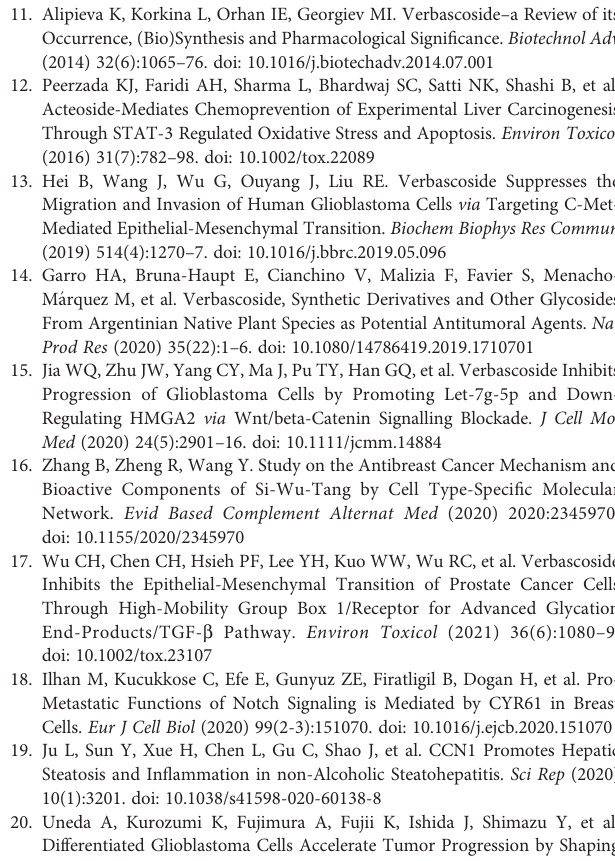
Supplementary Figure 1 | The IC50 values of VB treating A2780 and SKOV3 cells at 48 h were calculated based on the CCK8 assay. Supplementary Figure 2 | VB inhibits the malignant characteristics of OC cells via deactivating the CCN1-mediated AKT/NF- k B pathway. (A) The viability of A2780 and SKOV3 cellswas examinedusing the CCK8 assay. (B, C) Themigration and invasion of A2780 and SKOV3 cells was measured by transwell assay. Scar bar = 50 µm. (D) The protein levels of p-AKT/AKT and p-p65/p65 were detected by western blotting in A2780 and SKOV3 cells. A2780 and SKOV3 cells were treated with si-CCN1, lenti-CCN1, or/and 20 µM VB. Each treatment was replicated three times. Error bars represent mean ± SD; ** P < 0.01 vs. the si-CCN1 group; ## P < 0.01 vs. the lenti-CCN1